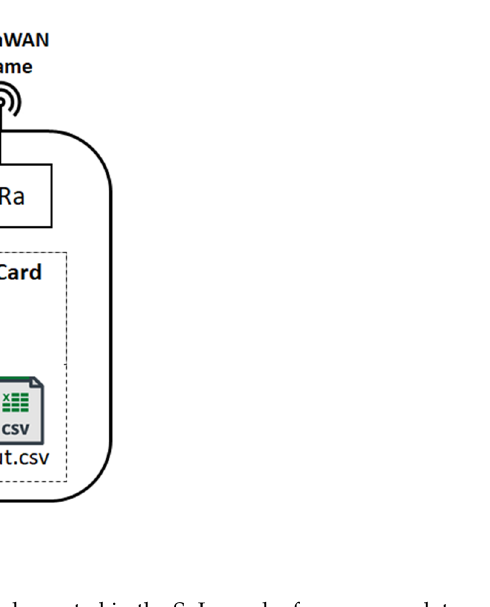
Figure 5. Architecture of the firmware implemented in the SoLo node: from sensor data reading to LoRaWAN transmission.